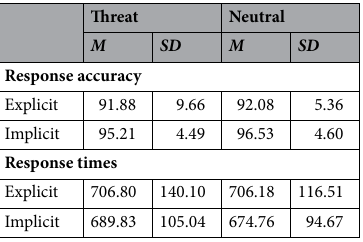
Table 3. Mean response accuracy (%) and time (ms) and SD for each experimental condition.